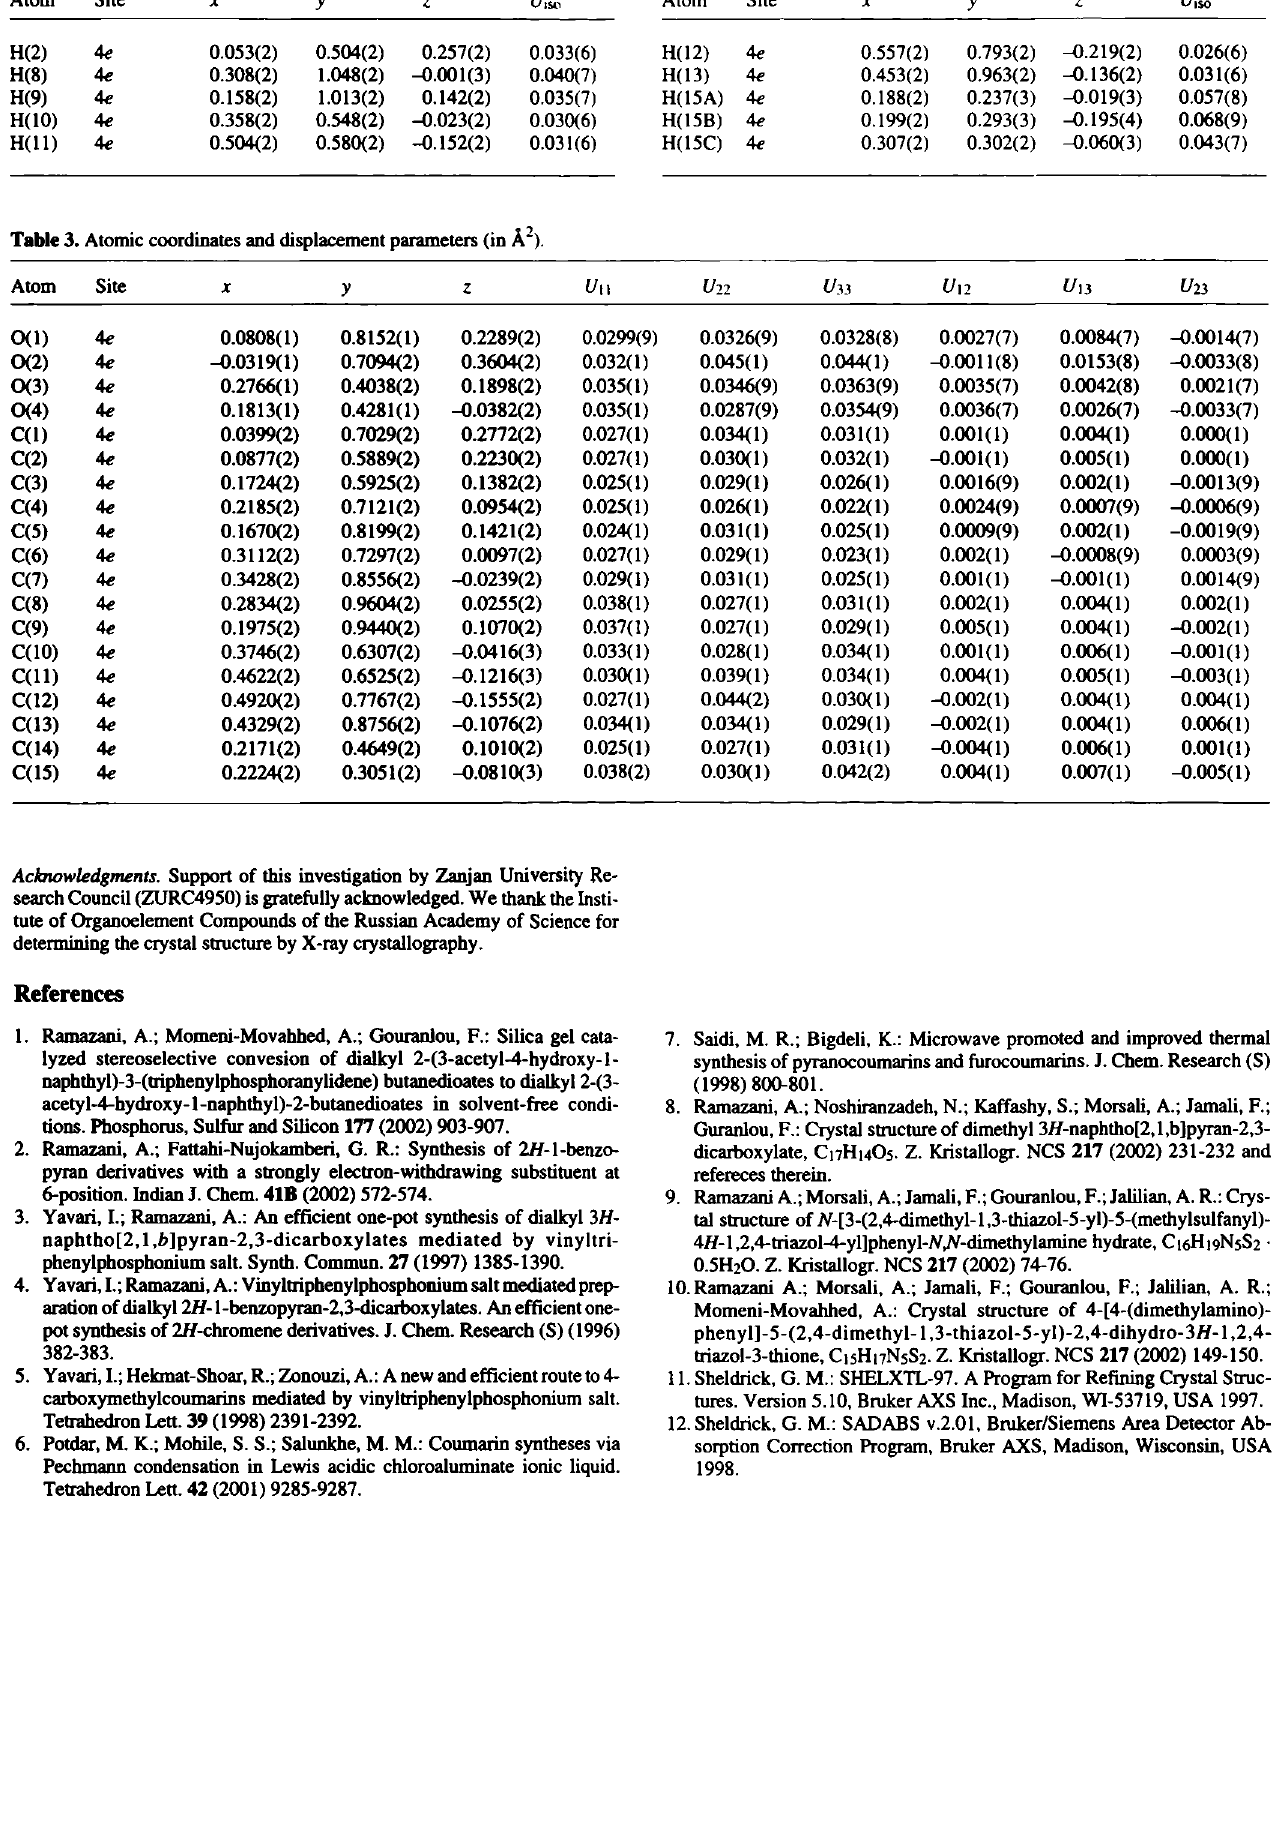
Table 3. Atomic coordinates and displacement parameters (in Â 2